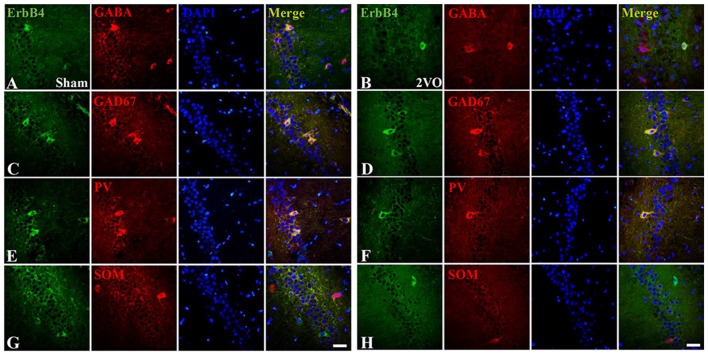
The co-localization of ErbB4 with GABAergic cells (GABA, GAD67, Parvalbumin (PV) and Somatostatin (SOM)) at 28 days. The representative images in the sham group are listed in the left four columns (A,C,E,G) and the images in the 2VO group are listed in the right (B,D,F,H). Horizontal bar = 50 μm. Note that ErbB4 is expressed in GABA, GAD67 and PV-positive cells, but not in SOM-positive cells.